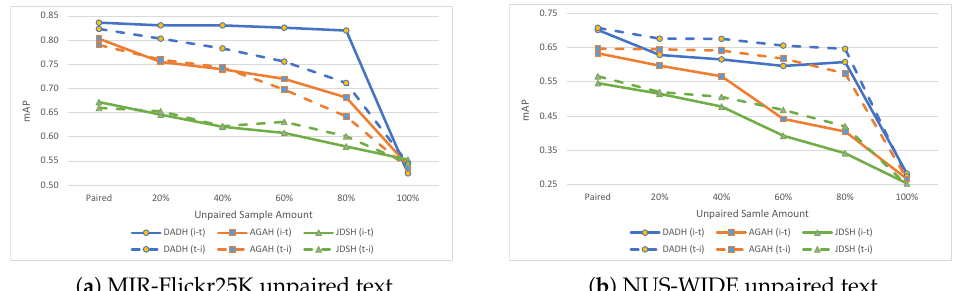
Figure 6. Results (mAP) on MIR-Flickr25K and NUS-WIDE with unpaired text, i.e., text with no corresponding images. The ‘Paired’ points show results when training with a fully paired training set. Subsequent points show results with increasing amounts of unpaired text in the training set in increments of 20%.